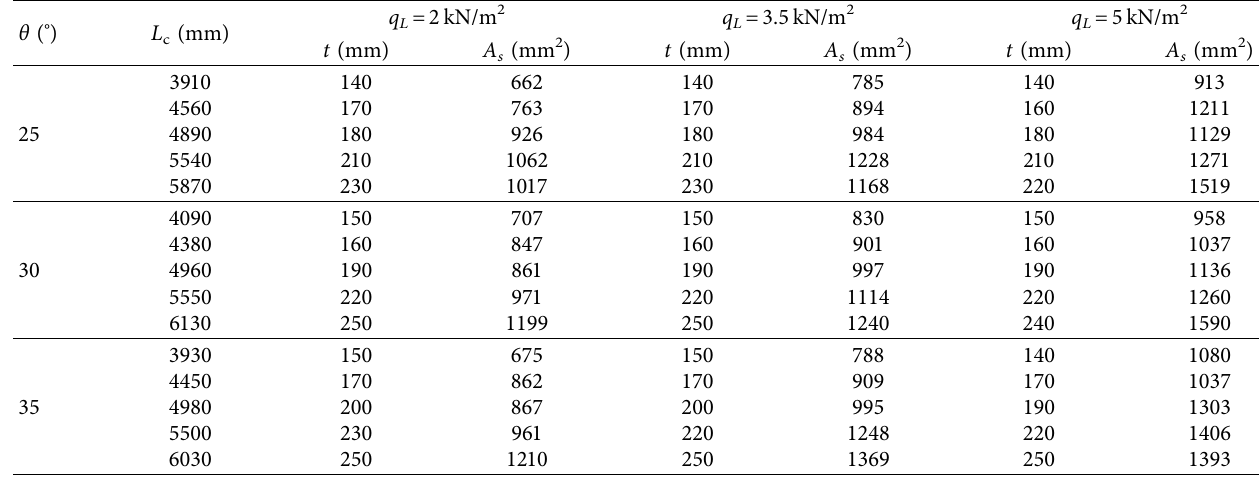
Table 4: Te required thickness and the steel area in the stair